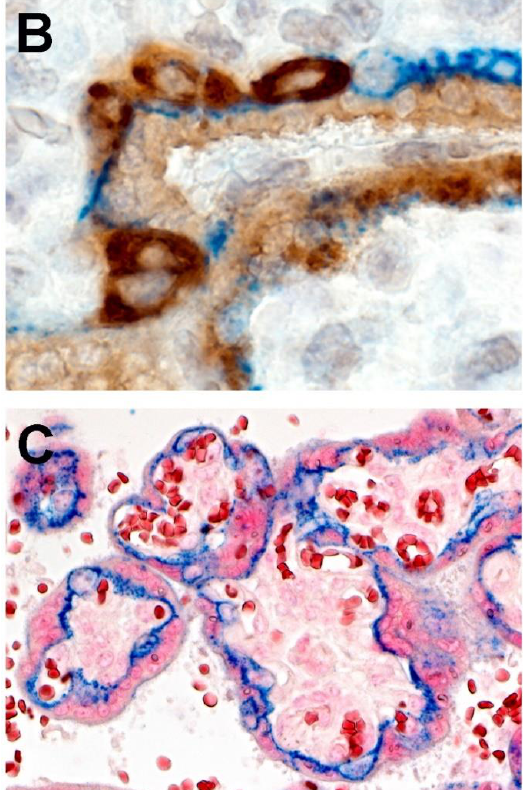
Figure 8. E-cadherin antibody staining of placenta to demonstrate cytotrophoblast. ( A , B ) . Double staining with antibodies to E-cadherin and SARS-CoV-2 nucleocapsid protein. Threadlike, delicate and continuous linear staining for E-cadherin (blue) assists in delineating the cytotrophoblast cells staining intensely positive for SARS-CoV-2 nucleocapsid protein from the weaker staining syncytiotrophoblast layer. Image ( B ) is a higher magnification of cytotrophoblast cells present in image ( A ). ( C ) . A control slide of uninfected placenta showing the surface of the syncytiotrophoblast staining negative for E-cadherin. Linear positive staining (blue) is present at the base of the syn- cytiotrophoblast, which extends around the outer cell membranes of the cytotrophoblast. Double staining with antibodies to E-cadherin and SARS-CoV-2 nucleocapsid protein. ( A ), Double staining with antibodies to E-cadherin and SARS-CoV-2 nucleocapsid protein, × 20; ( B ), Double staining with antibodies to E-cadherin and SARS-CoV-2 nucleocapsid protein × 100; ( C ), Antibody to E-cadherin and nuclear red counterstain, ×